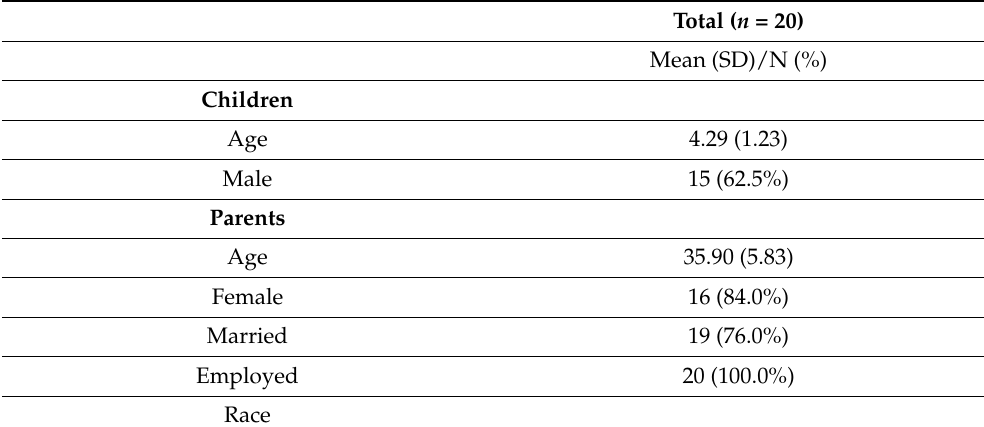
Table 1. Descriptive Statistics.